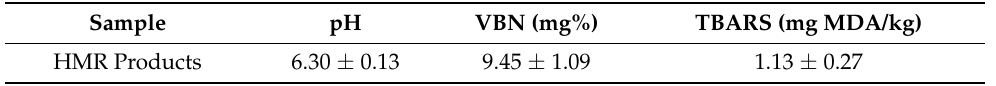
Table 6. Chemical characteristics of test seafood HMR products consisting of a mixture of AMPS, CSM, and sauce. Sample pH VBN (mg%) TBARS (mg MDA/kg) HMR Products 6.30 ± 0.13 9.45 ± 1.09 1.13 ±